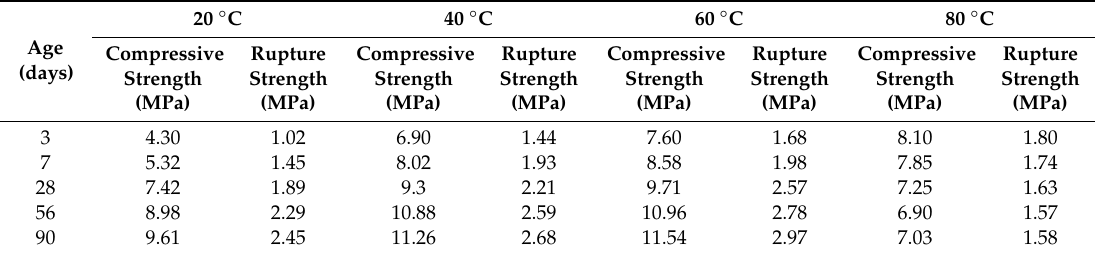
Table 4. The compressive strength and rupture strength of stone body of the HGTGS at di ff erent ages in di ff erent temperature